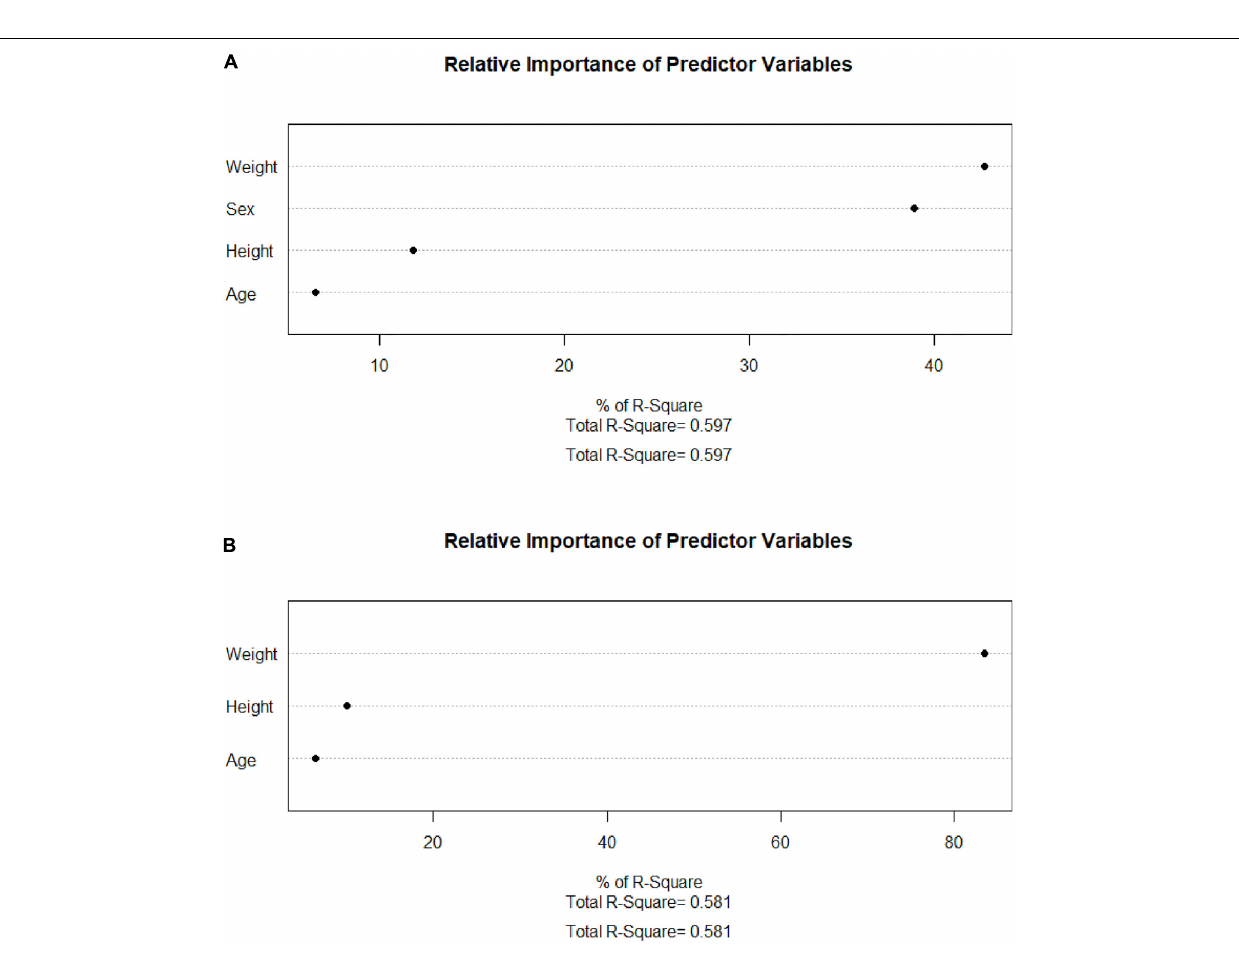
FIGURE 3 | Relweights of each variable. (A) SMI. (B) VFA. SMI: skeletal mass index at the third lumbar; VFA: visceral fat